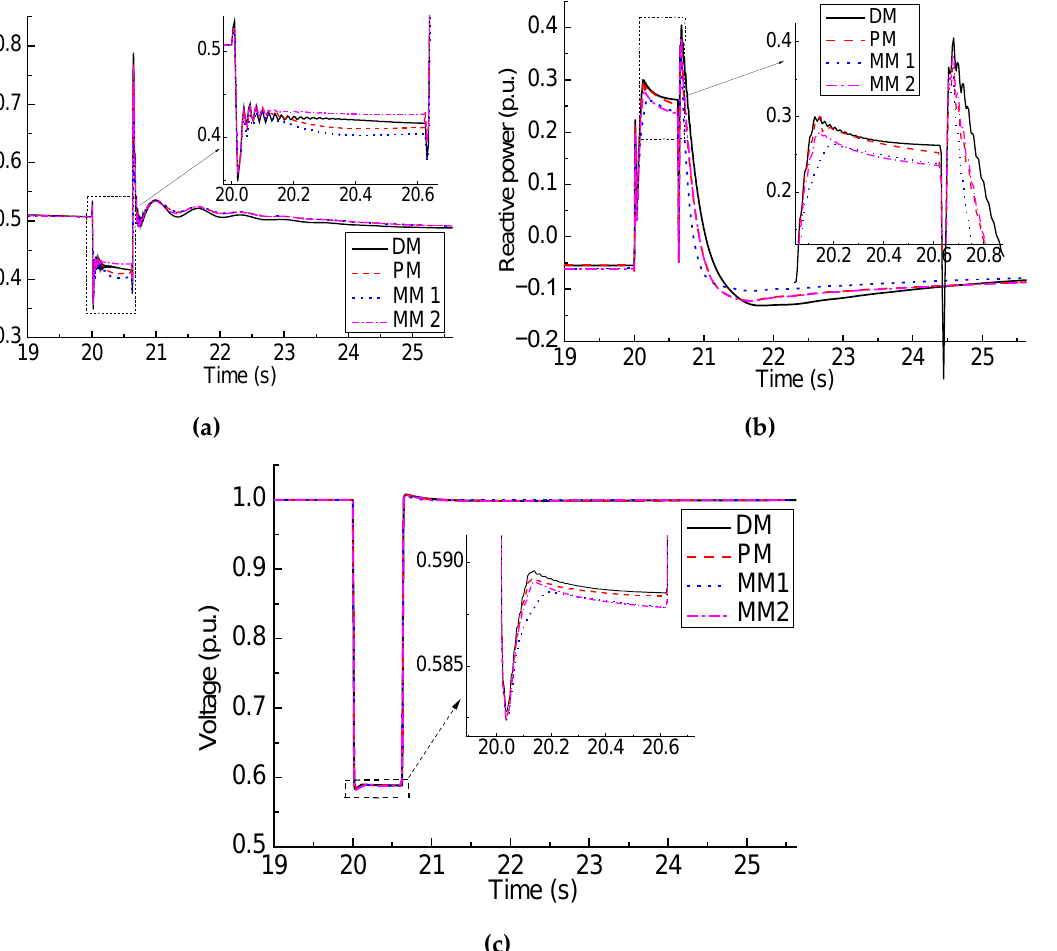
Figure 10. The dynamic responses of WF at POC in Case 3. ( a ) Active power. ( b ) Reactive power. ( c ) Voltage.